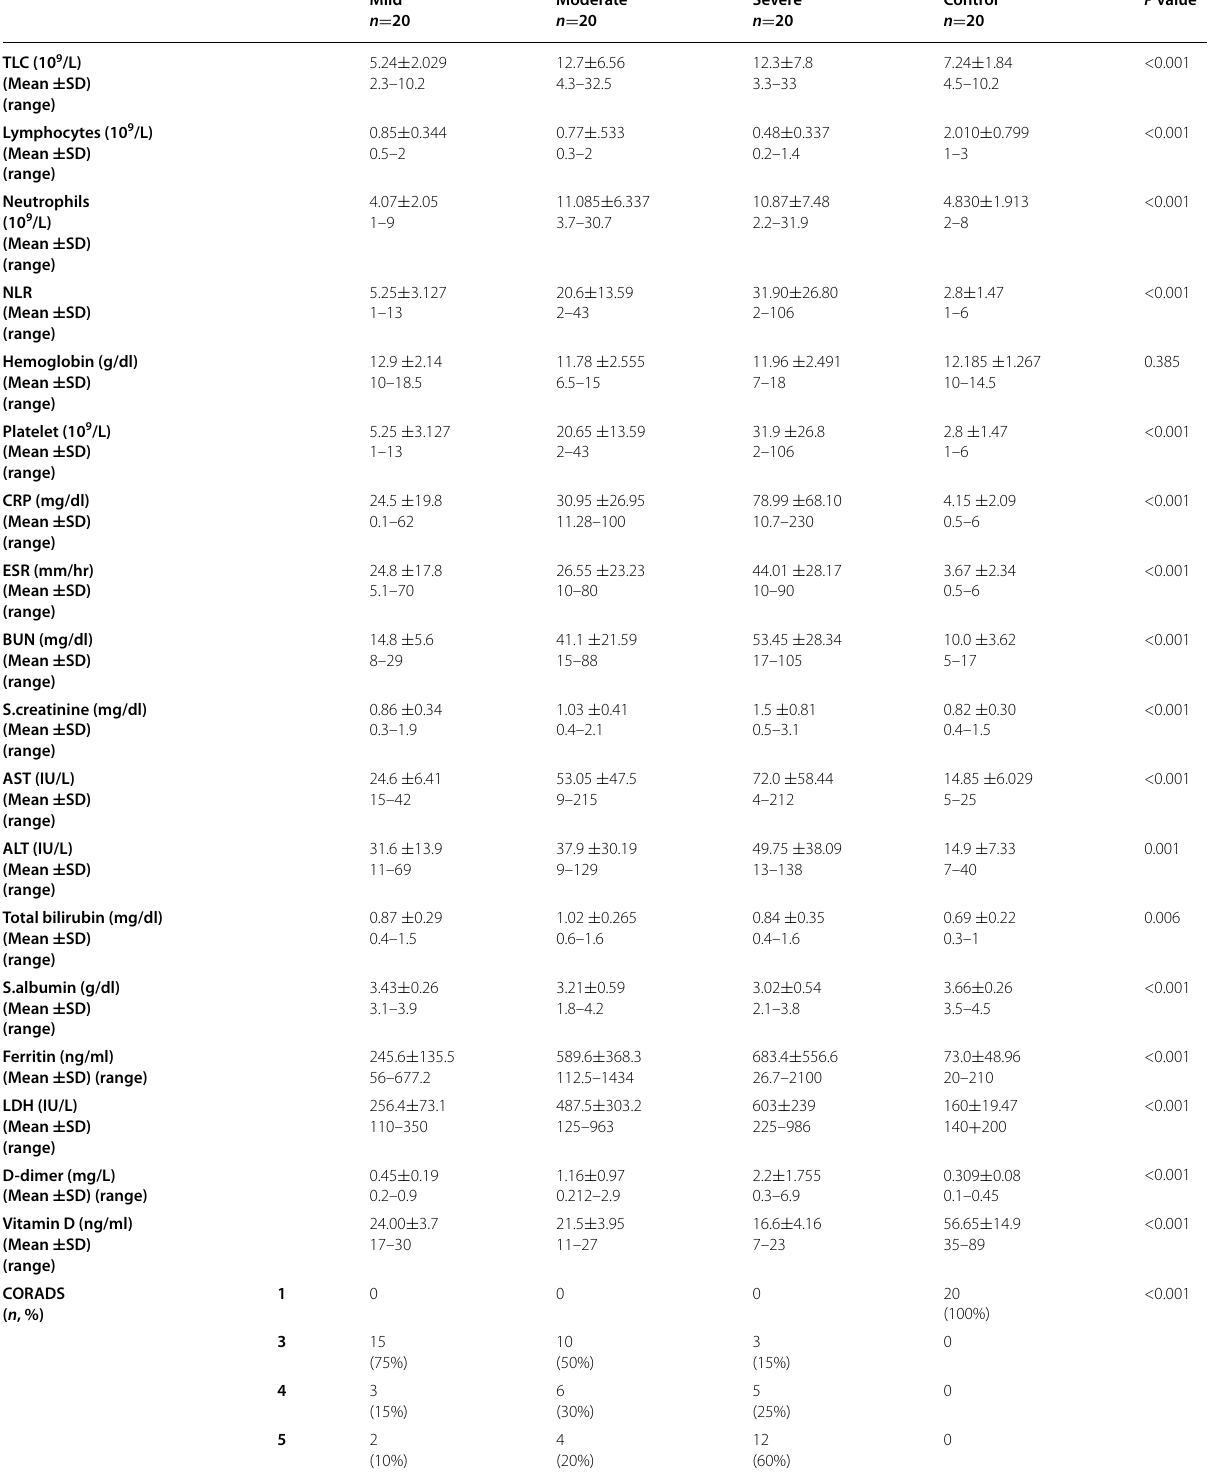
Table 2 Laboratory and radiologic findings of COVID-19 patient groups: mild, moderate, and severe and control